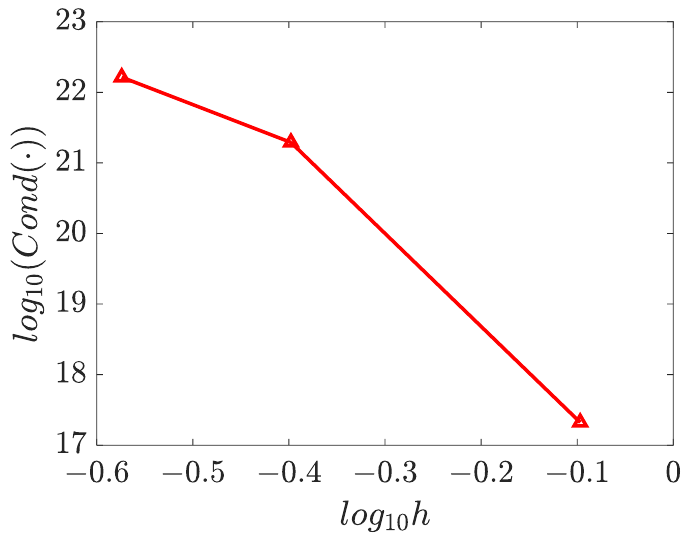
Figure 14. Condition number of stiffness matrix for the 2D constant parameter identification prob-